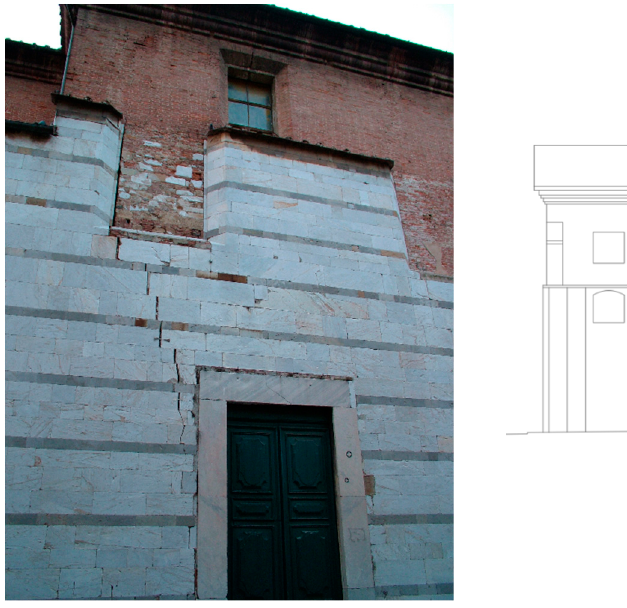
Figure 18. General view of the crack pattern on the rear façade.